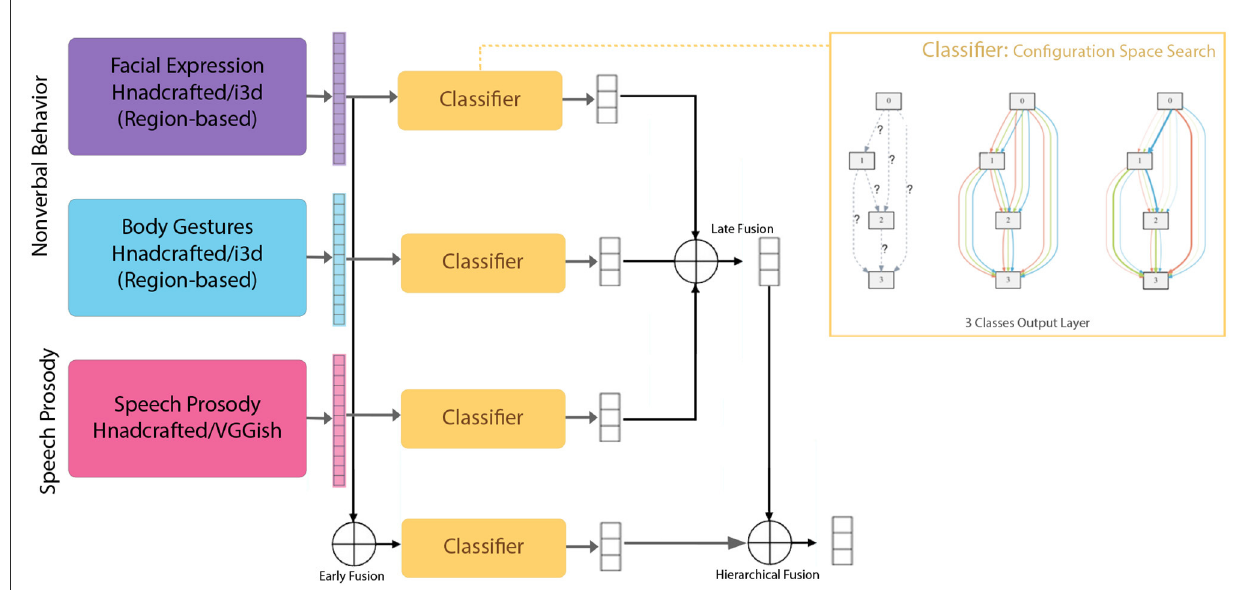
FIGURE2 Single modeling (and configuration space) and multimodal fusion approaches used in this work (early, late, and hierarchical fusion levels).